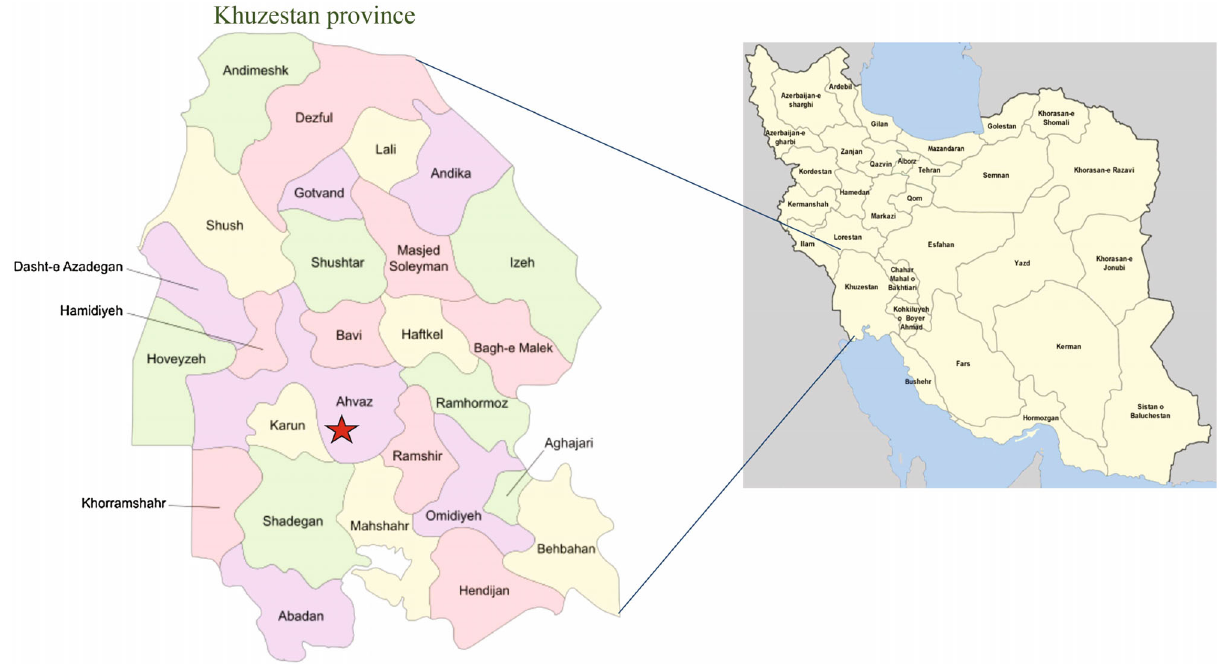
Figure 1: The map of Iran and Khuzestan Province in the southwest of Iran. The study region is shown with red Table 1: The serological results of toxoplasmosis in two groups of women with an abortion history and a normal delivery. Groups